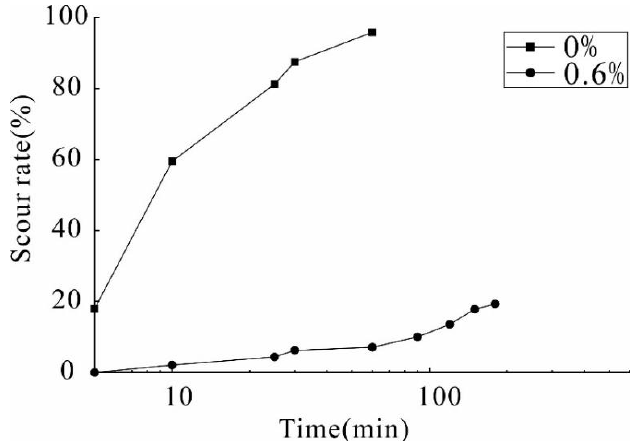
Figure 13. Soil loss curve.